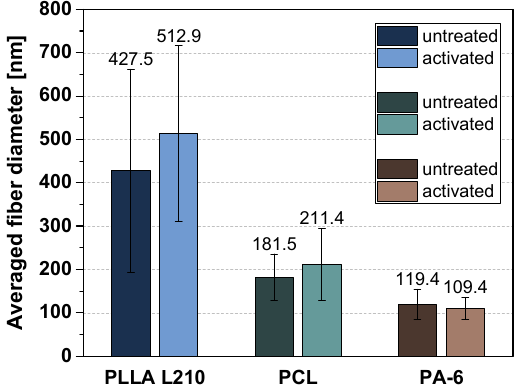
Figure 4. Fiber diameter of untreated and NH 3 -plasma functionalized PLLA L210, PCL and PA-6 nonwovens based on individual measurement points. For each polymer, 10 fibers were measured manually in 5 different SEM images ( n = 50).